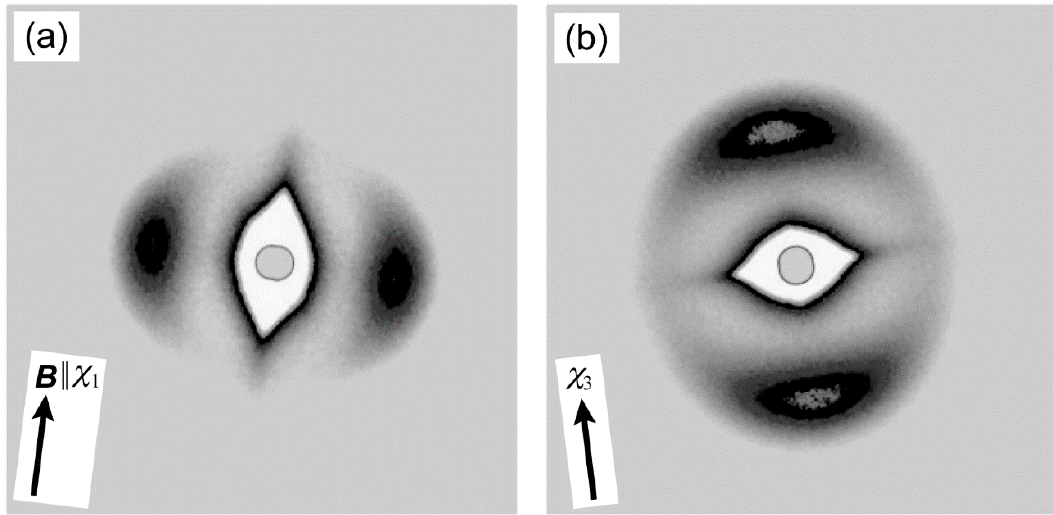
Figure 10. Small-angle X-ray scattering (SAXS) images of ( a ) PPAZn/PLLA-8TS, and ( b ) PPAZn/PLLA-8TR. The directions of the impinging X-rays were perpendicular to the χ 1 -axis and χ 3 - axis for ( a ) and ( b ),